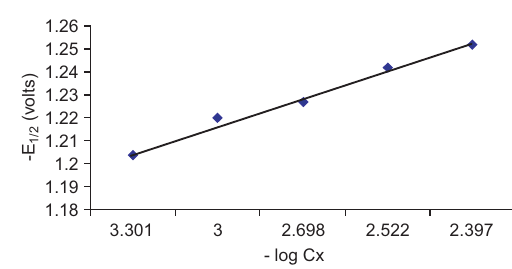
Figure 2 Direct current polarogram and differential pulse polarogram of Zn(II)-coumarin complex in ammonium tartrate (0.2 m ) pH 8.2 ± 0.1.